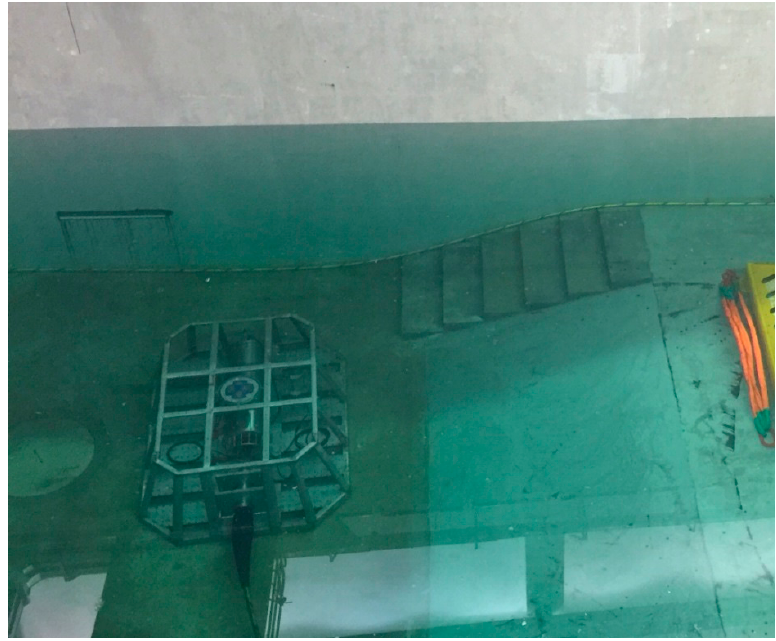
Figure 8. Tank Test for ESOCS.